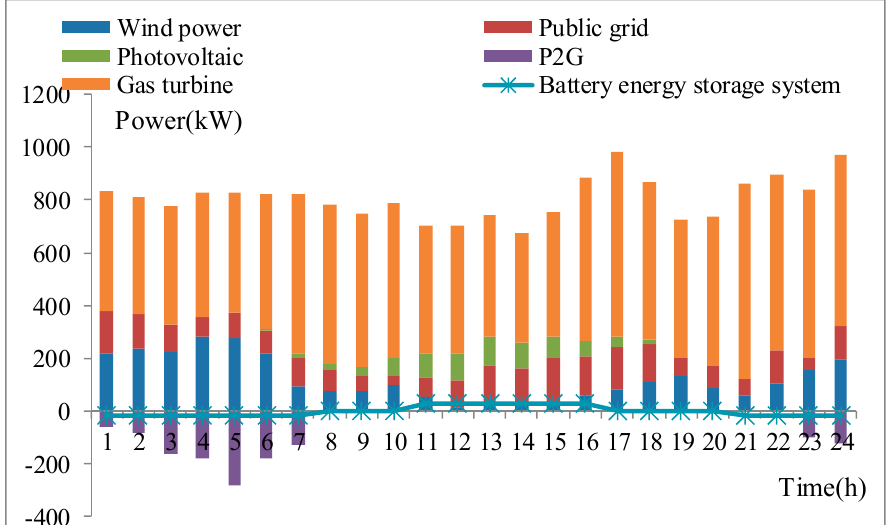
Figure 4. The output structure of each device in Scenario 2.